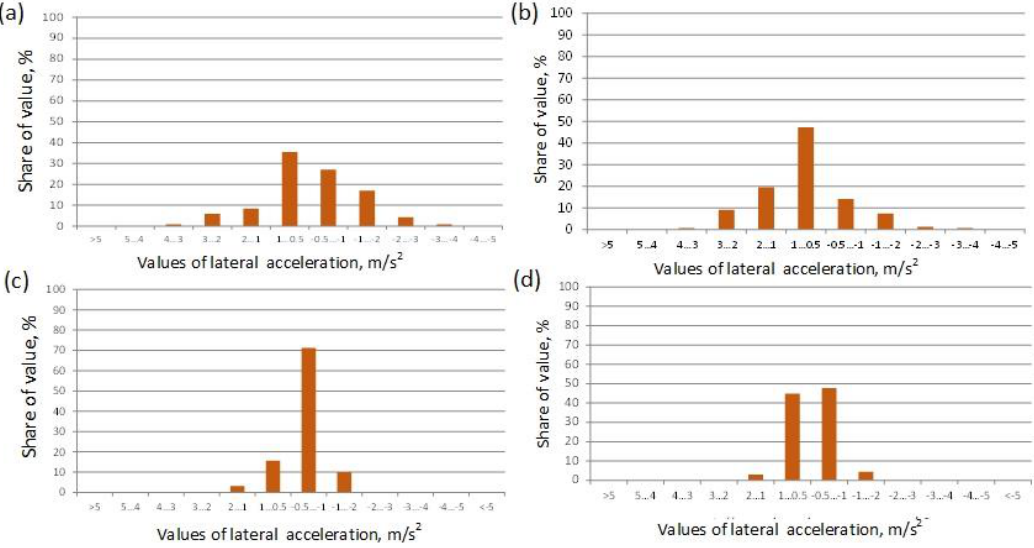
Figure 9. Distributions of the extreme values of lateral acceleration during turning maneuvers for various route sections; route sections: ( a ) city road; ( b ) suburban road; ( c ) expressway (dual carriageway); ( d ) highway. Table 2. Distribution of the extreme values of lateral acceleration for various route sections: (a) city road; (b) suburban road; (c) expressway (dual carriageway); (d) highway. Acceleration Distribution, %